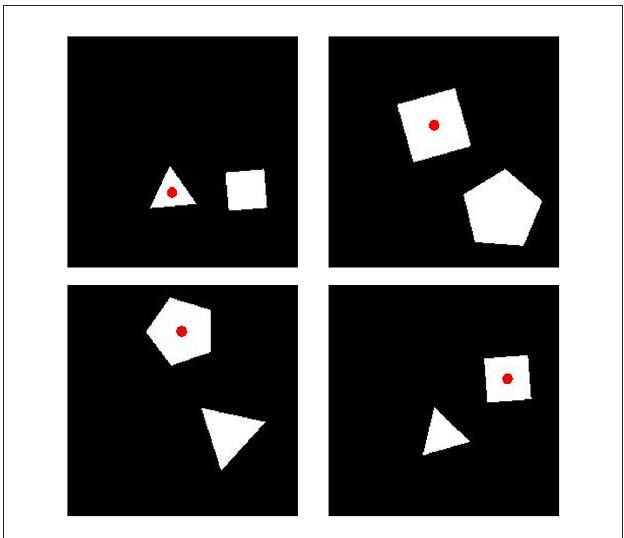
FIGURE8 Sample training images for Experiment 3a. (Top) Two “Fewer” images. (Bottom) Two “More” images. Category membership was determined by the position of the small, red dot, placed on the polygon with either more or fewer sides.